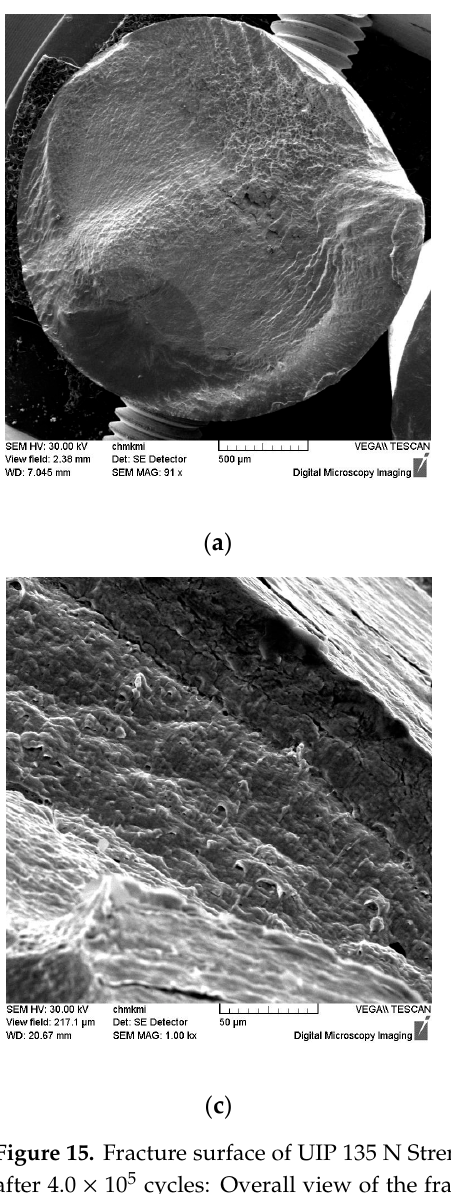
( d ) Figure 14. Fracture surface of UIP 2 × 85 N Strenx 700 MC specimen loaded at 415 MPa and fractured after 3.23 × 10 7 cycles: Overall view of the fracture ( a ), detail of fish-eye fatigue crack initiation ( b ), delamination of the strengthened surface layer ( c ) and final fracture with area of finer dimples in the strengthened surface layer ( d ). The fact that the fatigue crack always initiated in the HAZ shows, that this zone was the weakest point of the welded joint in terms of cyclic loading. The shift of the fatigue crack initiation point to subsurface volumes of material was caused by an increase of the dislocation density in the treated surface layer. Further dislocation slip (micro-plastic deformation), which is necessary for the fatigue